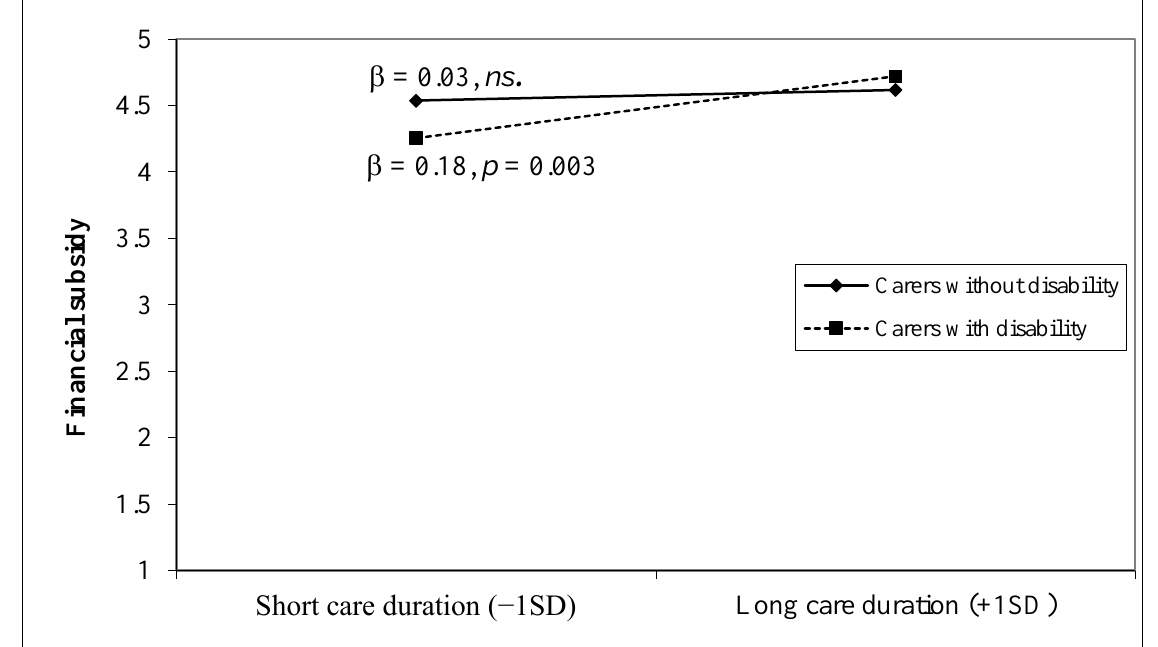
Figure 3. Relationship between care duration and perception of the importance of service improve- ment among carers on financial subsidy.